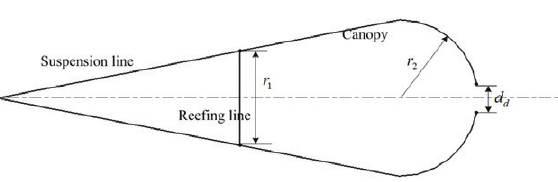
a) Structure mesh b) Fluid Figure 2. Parachute system